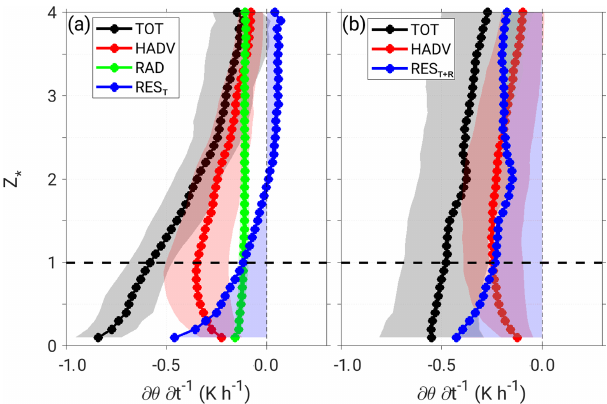
Figure 5. (a) Vertical profiles of local total cooling rate (TOT) and estimates of contribution of horizontal advection (HADV) and net radiation flux divergence (RAD) terms for the Savè site during the stable and jet phases. (b) Vertical profiles of TOT and HADV for the Kumasi site during the stable and jet phases. The residual term includes the turbulent flux divergence at Savè (RES T ) and both the net radiation and turbulent flux divergences at Kumasi (RES T + R ) . The shading indicates the standard deviation. The horizontal dashed line ( Z ∗ = 1) indicates the CBH when the stratus clouds